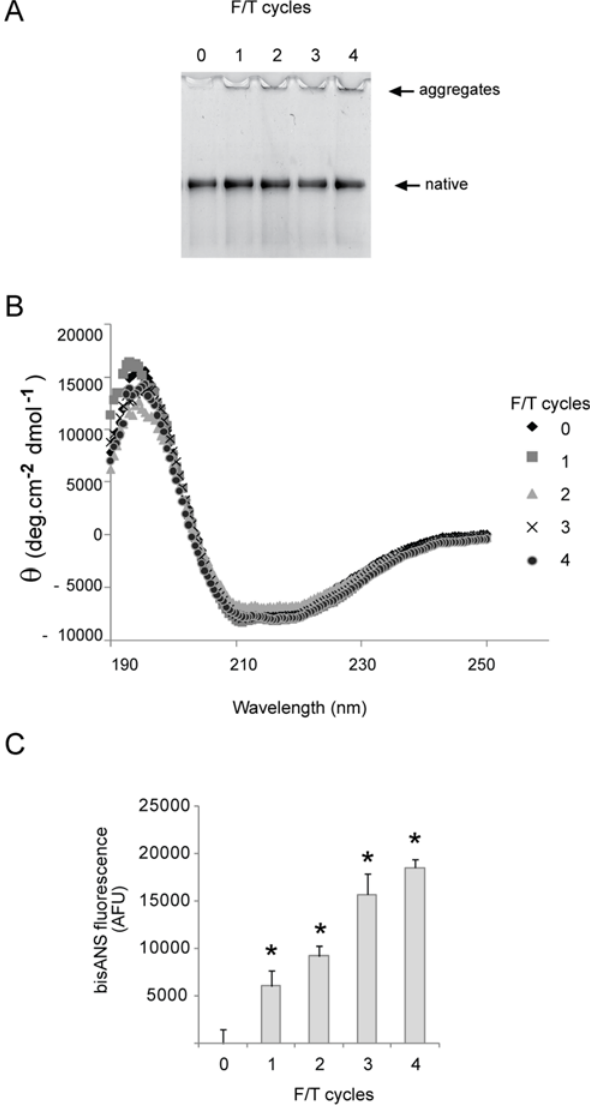
Fig 3. The effect of freezing and thawing on the structure and surface hydrophobicity of α 2 M. (A) Image of a native PAGE (3 – 8% Tris-acetate) gel showing the migration of α 2 M in 20mM sodium phosphate buffer, pH 7.4 after 0 – 4 cycles of rapid freezing in liquid nitrogen followed by thawing at 37°C (F/T cycles). (B) CD spectra of α 2 M as described in (A). (C) BisANS fluorescence measurements (excitation 360 nm, emission 490 nm) for α 2 M as described in (A). * Denotes significant increases or decreases in soluble α 2 M, bisANS fluorescence or trypsin binding compared to a matched α 2 M sample stored at 4°C (Student ’ s t-test p < 0.01).